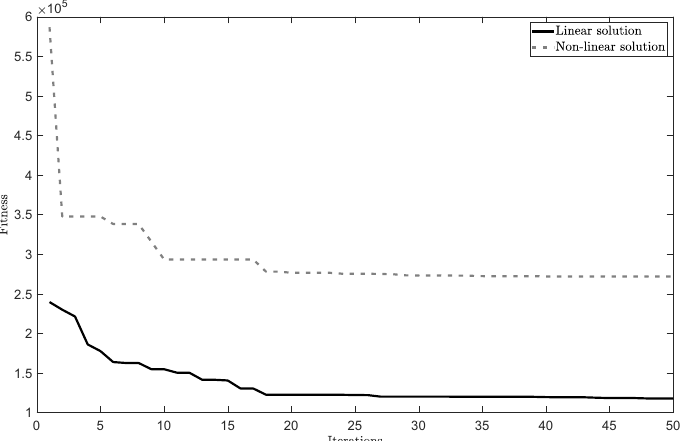
Figure 11. Fitness evolution in the CRO-SL for the submerged arch design case in which the span B is